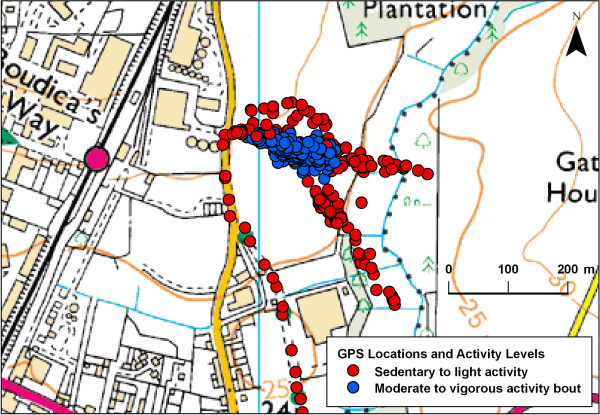
A child undertaking unstructured play and exploration of uncultivated land. Data Crown Copyright © Ordnance Survey. Used under license.